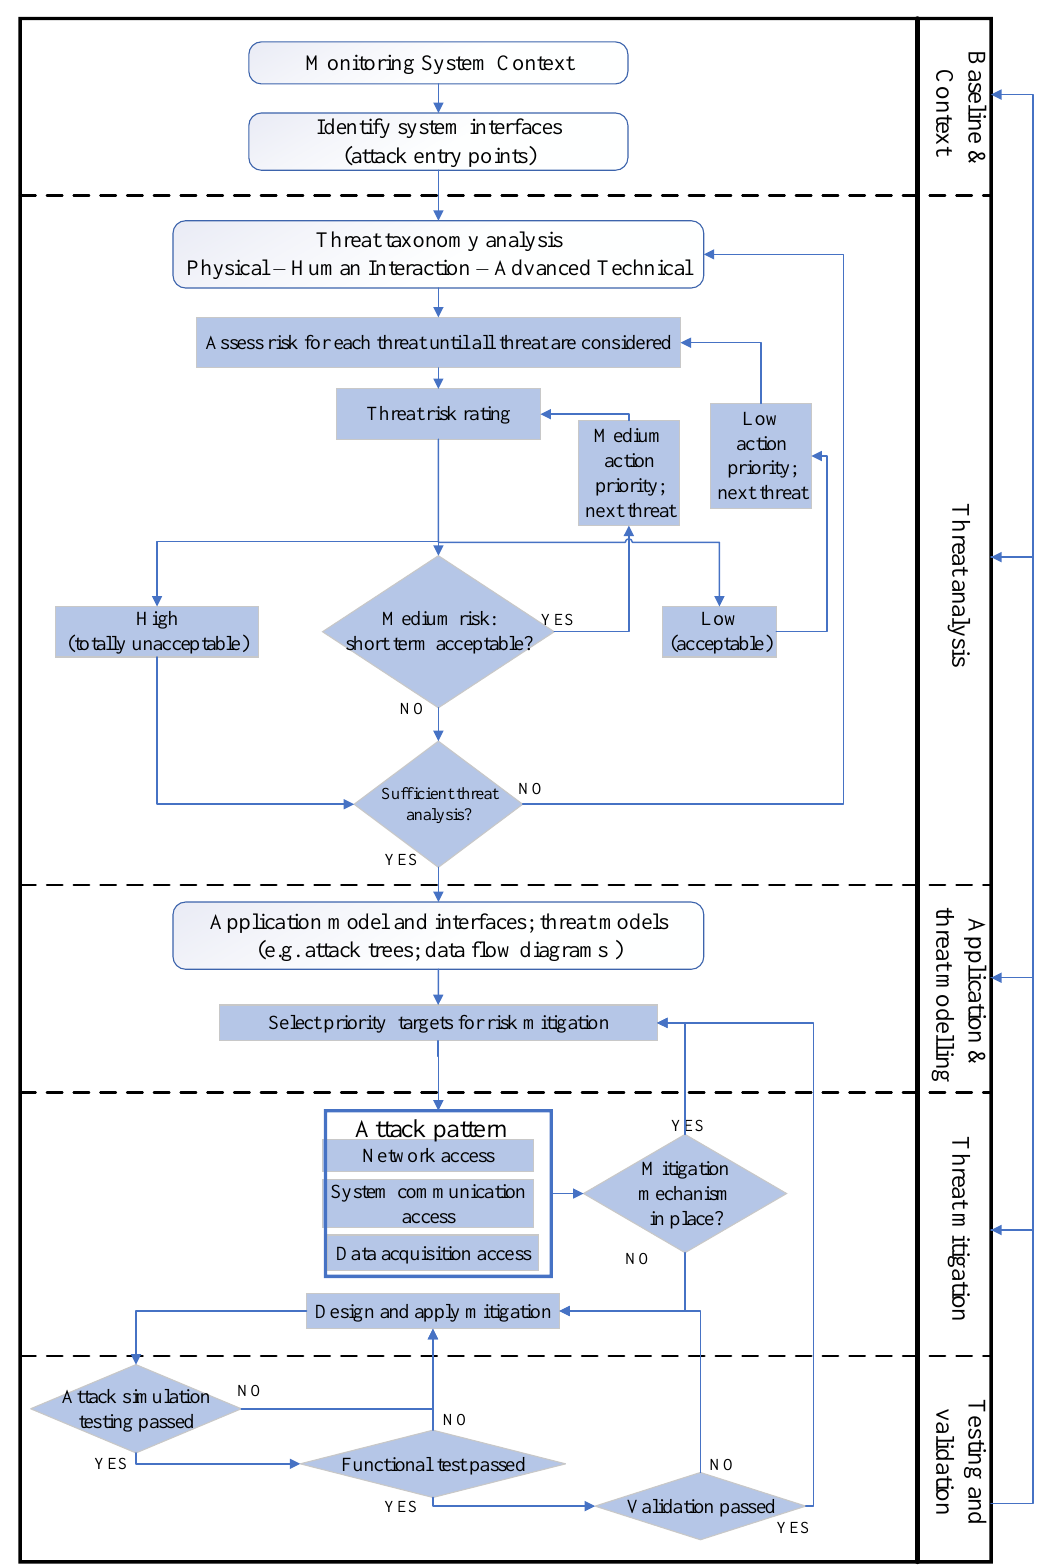
Figure 3. Design thinking for IoT device security in production environments.